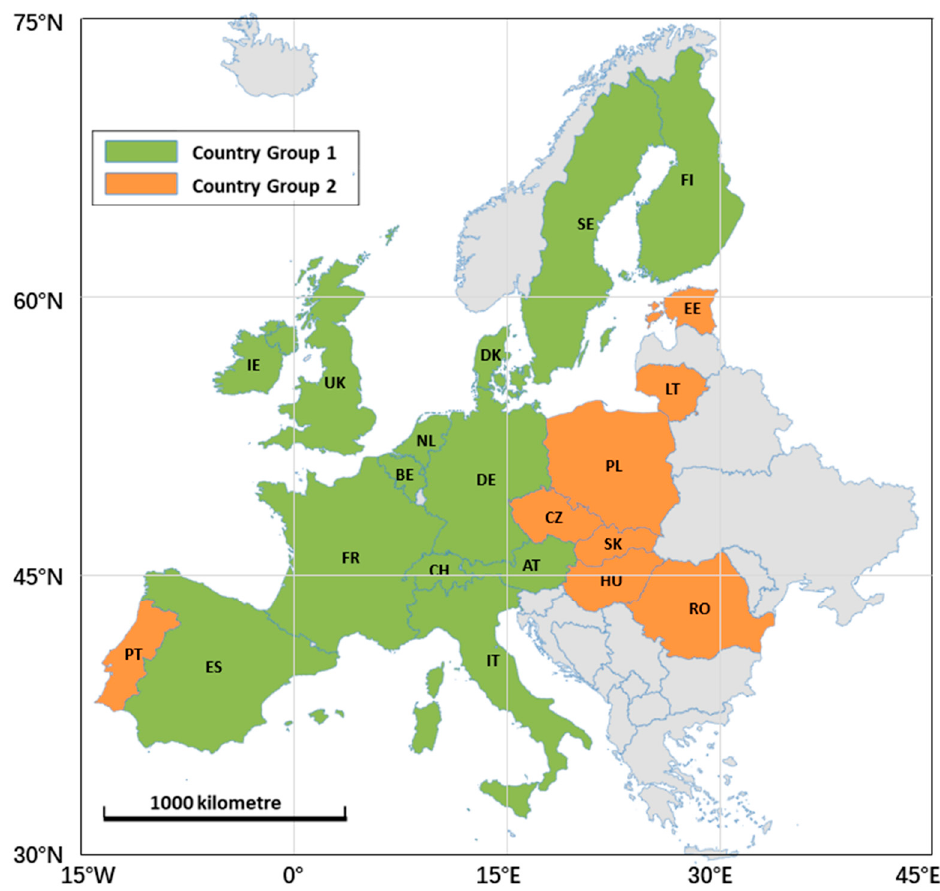
Figure 3. Geographical distribution of the final classifications of 21 European countries related to their background characteristics. Table 3. The average values of four background indicators related to different country groups and different years, as well as the p ‐ value from the hypothesis testing.